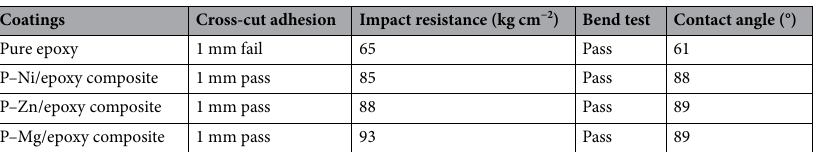
Table 2. Cross-cut adhesion, impact resistance, bend test and contact angle for coated carbon steel with neat epoxy and new nanocomposite coatings.